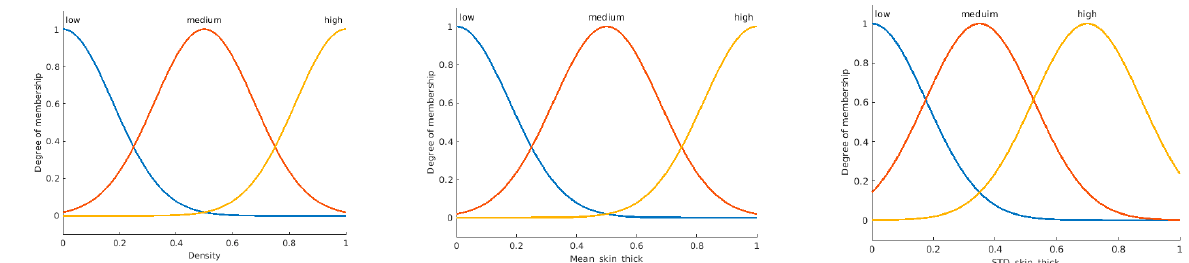
Figure 7. ( a ) The architecture of the proposed Type-1 fuzzy inference system. ( b ) Singleton output membership function used in the designed Type-1 fuzzy system.